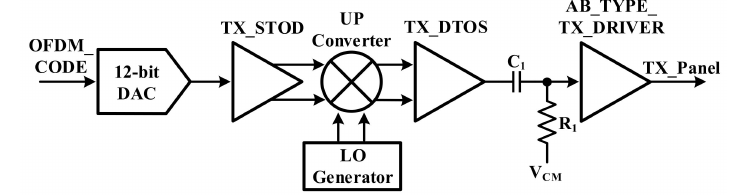
Figure 10. Architecture of